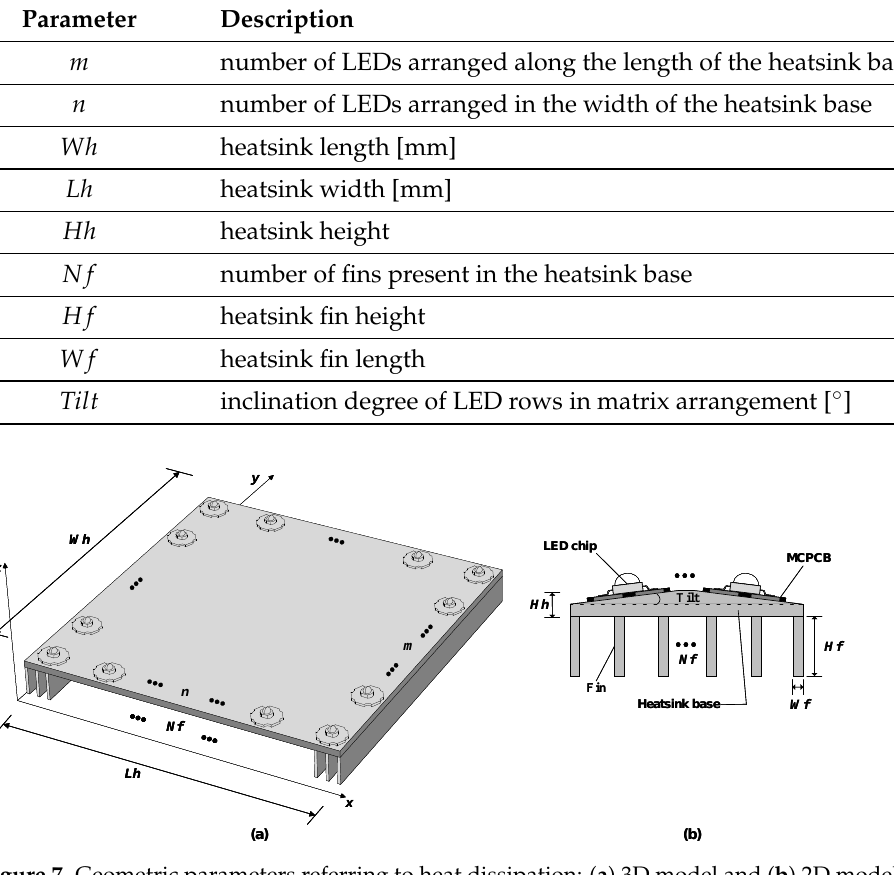
Figure 7. Geometric parameters referring to heat dissipation: ( a ) 3D model and ( b ) 2D